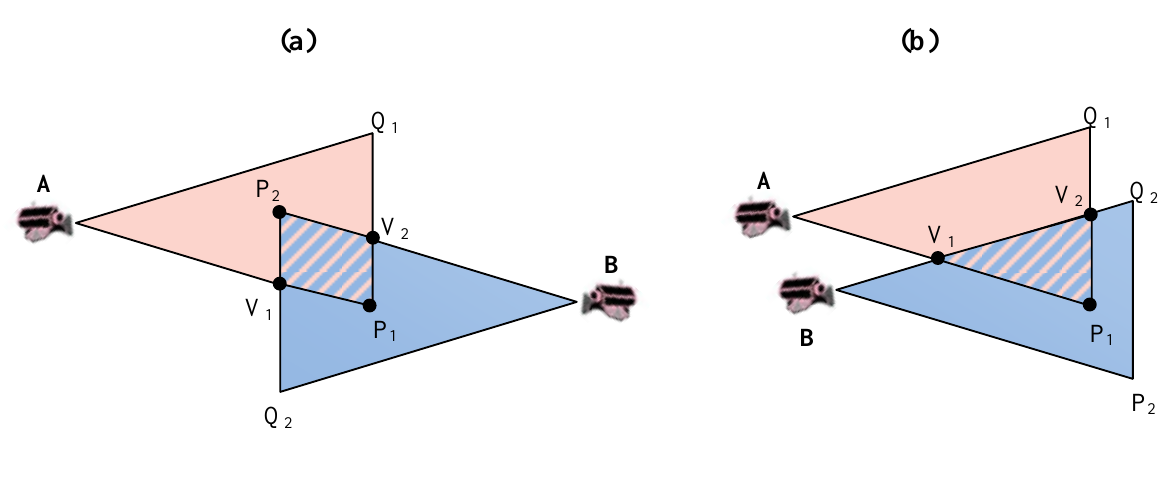
Figure 4. Examples of side intersection in only one point, for instance AP perimeter of the other triangle in only V